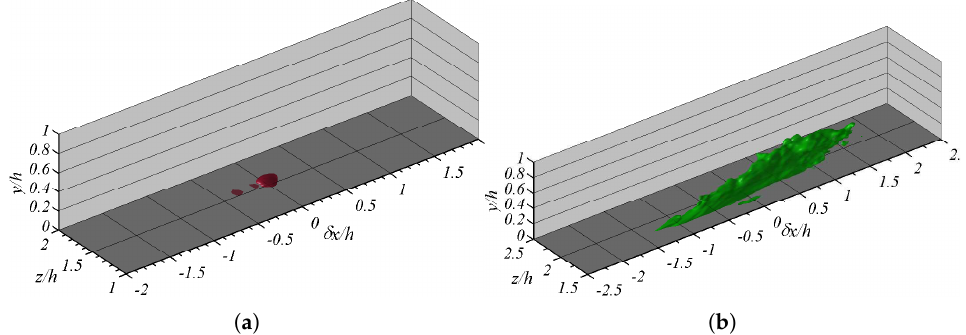
Figure 6. The two-point correlation of streamwise velocity fluctuations, ρ uu ( a ) behind the jets and ( b ) between the